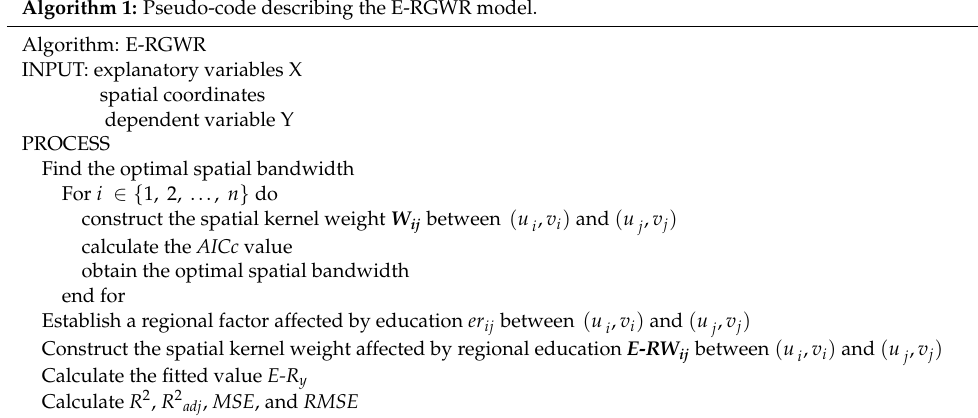
Algorithm 1: Pseudo-code describing the E-RGWR model. Algorithm: E-RGWR INPUT: explanatory variables X